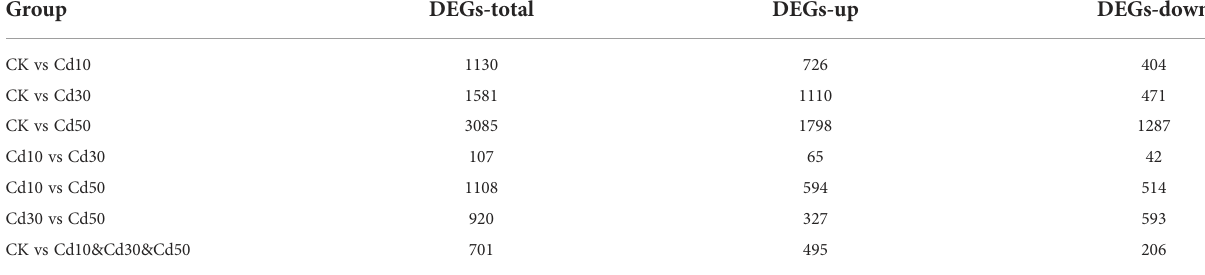
TABLE 1 The analysis of differentially expressed genes (DEGs). Group